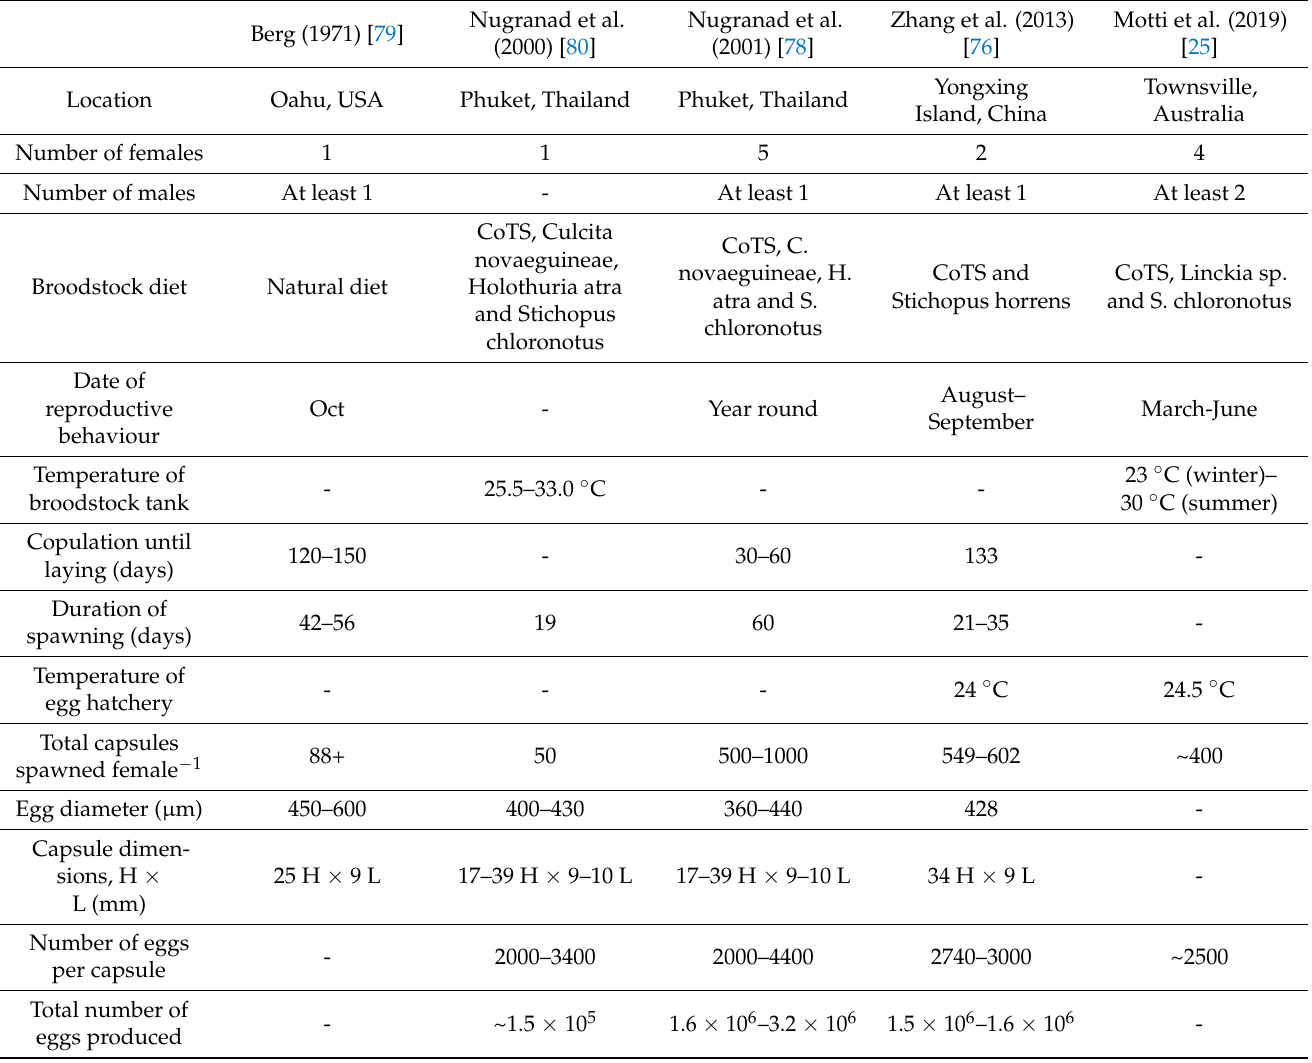
Table 2. Reproductive statistics for Charonia tritonis reported from ex situ breeding programs. CoTS = Crown-of-Thorns starfish; PSU = practical salinity